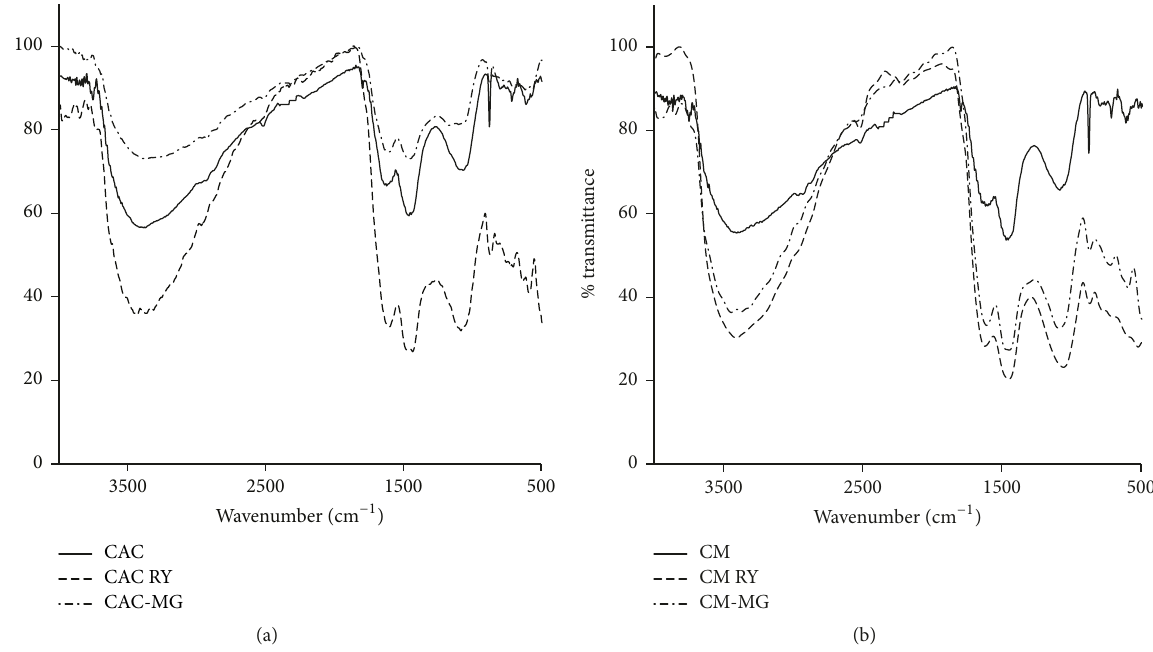
increased when the samples were in contact with the dye solution, which indicated that dye adsorption occurred on the